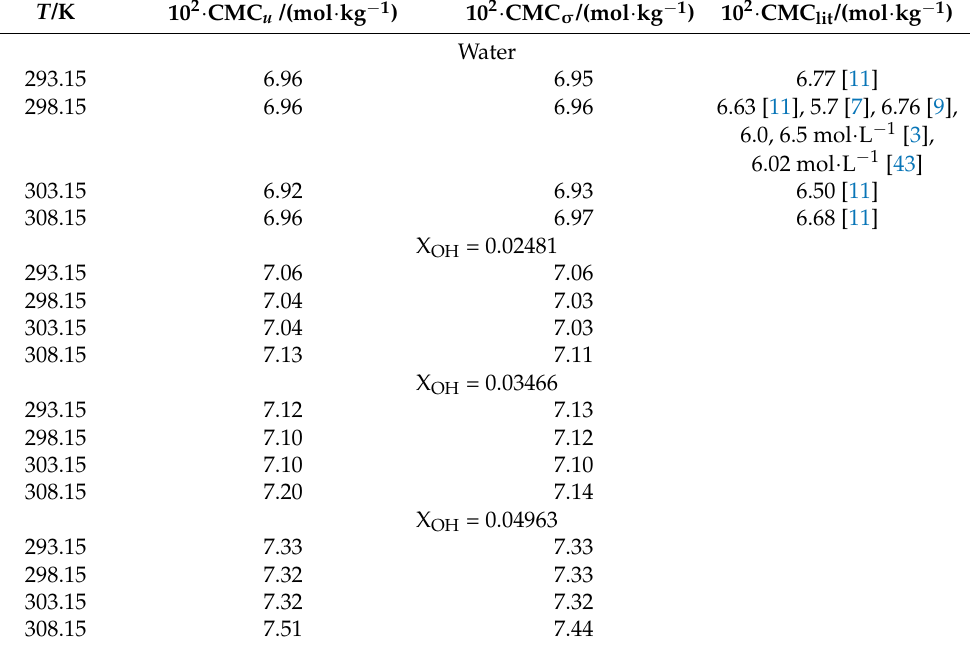
Table 5. Critical micelle concentration of decyltrimethylammonium bromide (C 10 TAB) in water and aqueous solutions of 1,2-propanediol at temperatures between T = 293.15 K and 308.15 K at 75 kPa from sound velocity and surface tension